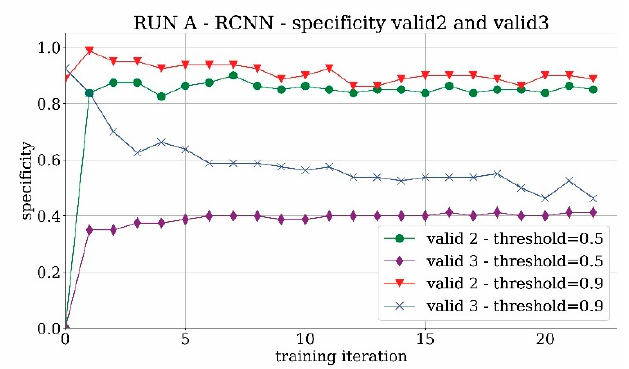
Figure 9. Specificity trend of RUN A with valid 2 and 3.